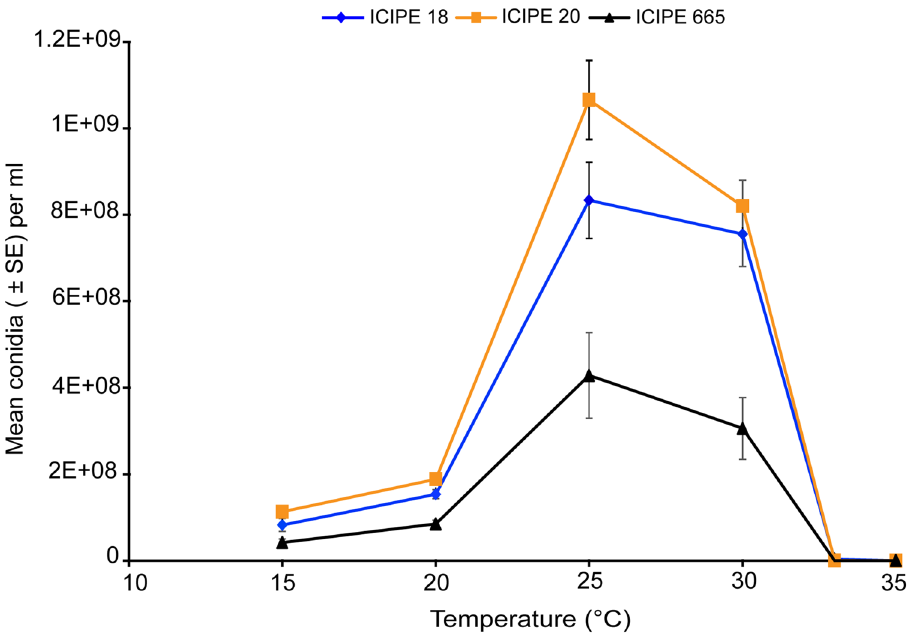
Figure 3. Effect of temperature on conidial production of the three Metarhizium anisopliae isolates ICIPE 18, 20 and 665. Error bars indicate the standard error of the mean at 95% CI (n = 72; N = 4; Tukey’s HSD